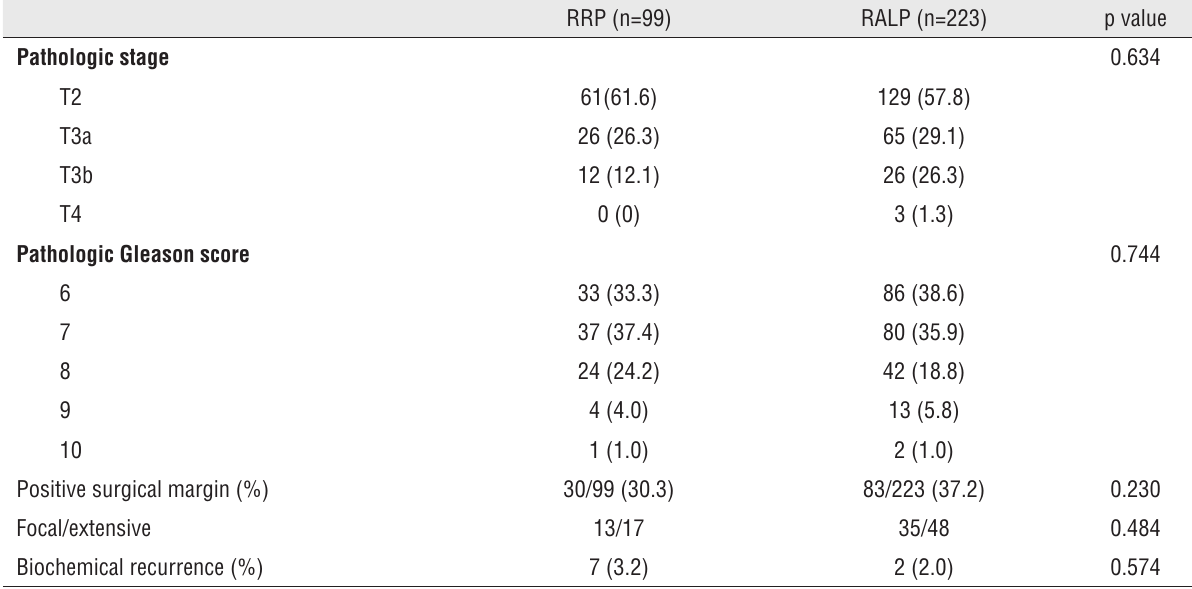
Table 2 - pathologic